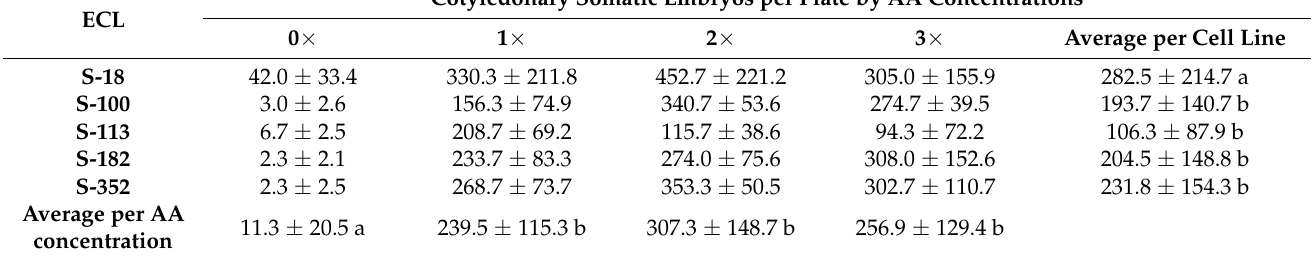
Table 9. Effect of amino acid (AA) concentration on somatic embryo maturation efficiency of sugi embryogenic cell lines (ECLs). Data are presented as the mean ± SD (standard deviation) of the number of cotyledonary somatic embryos per plate from three replicates for each ECL matured on media containing different concentrations of AAs.